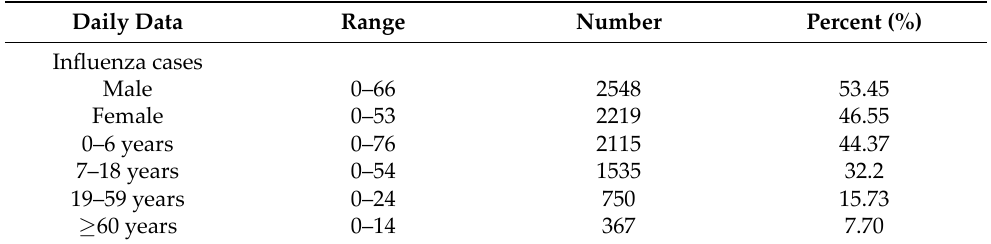
Table 1. Demographic characteristics of outpatient visits of influenza cases in Jinan City from 1